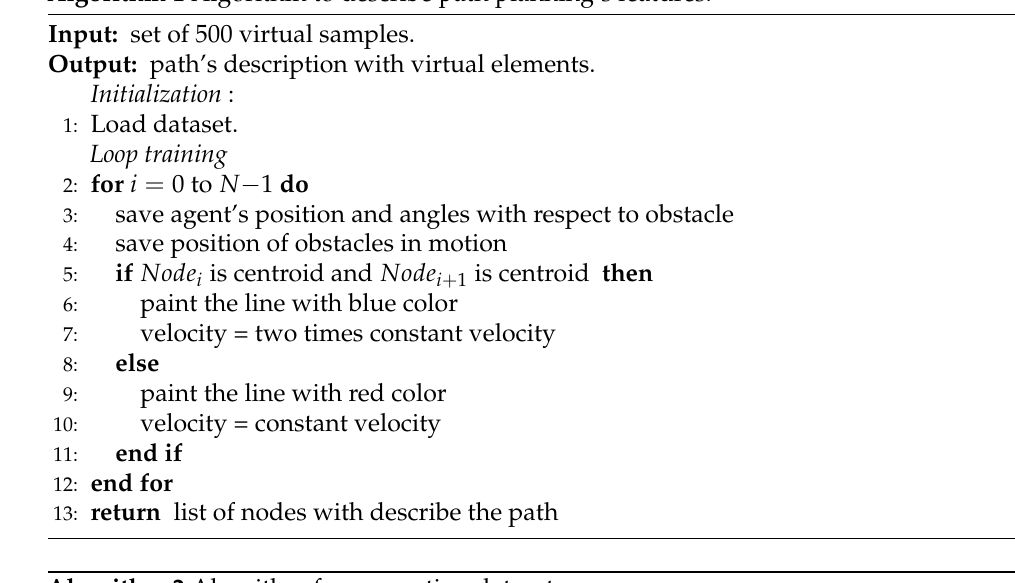
Algorithm 1 Algorithm to describe path planning’s features.